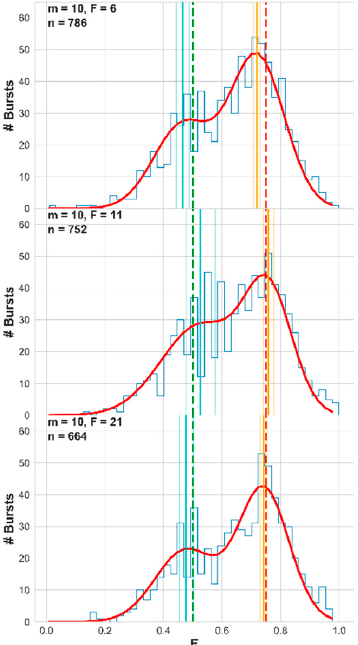
Figure 8. Simulations of single-molecule Förster resonance energy transfer (smFRET) experiments with two FRET efficiency subpopulations—increasing the value of the photon rate threshold, F , improves the accuracy of the retrieved mean FRET efficiency. From top to bottom, each panel shows the resulting FRET histogram (blue), the best fit sum-of-two-Gaussians (red), the best-fit mean FRET efficiencies (orange and cyan vertical lines; dimmer lines show the error ranges), and the simulation ground-truth mean FRET efficiency values (dashed red and green vertical lines). These results are for the 60 s simulation of molecules a concentration of 62 pM, where the diffusion coefficient of the molecules was 90 μ m 2 /s, using the numerical PSF model, and the molecules were split to 10 with E = 0.75 and 5 with E = 0.5. The number of bursts in each histogram is also reported in each panel. The best fit values and the fitting error values are also reported in Table S3.